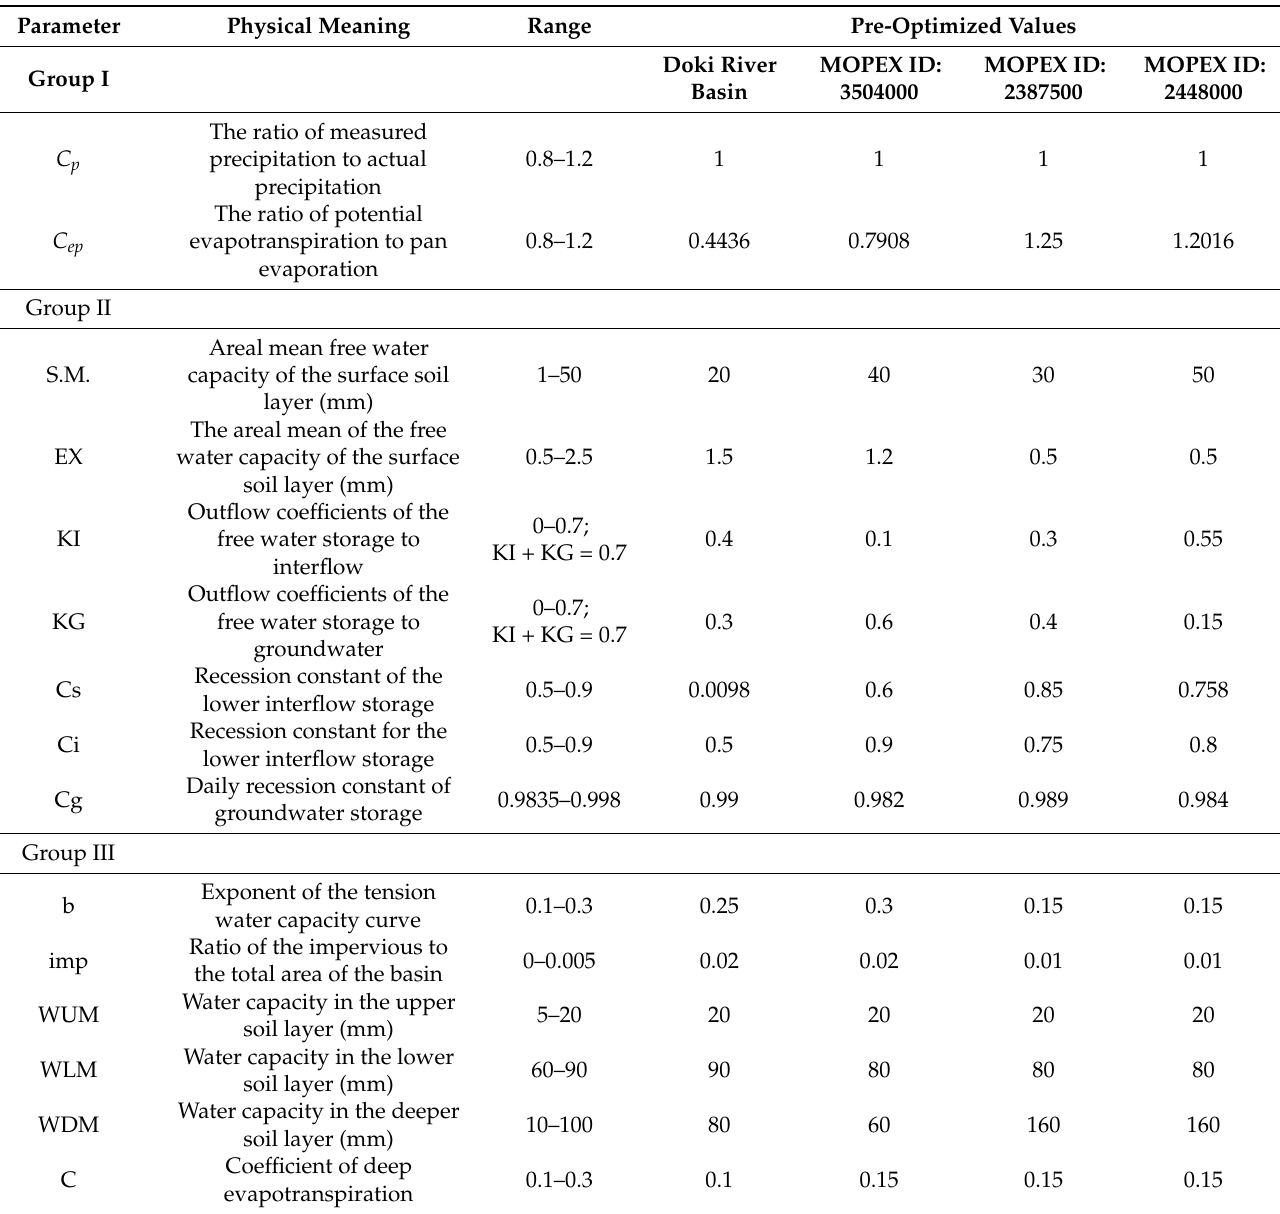
Table 3. Parameters in the XAJ